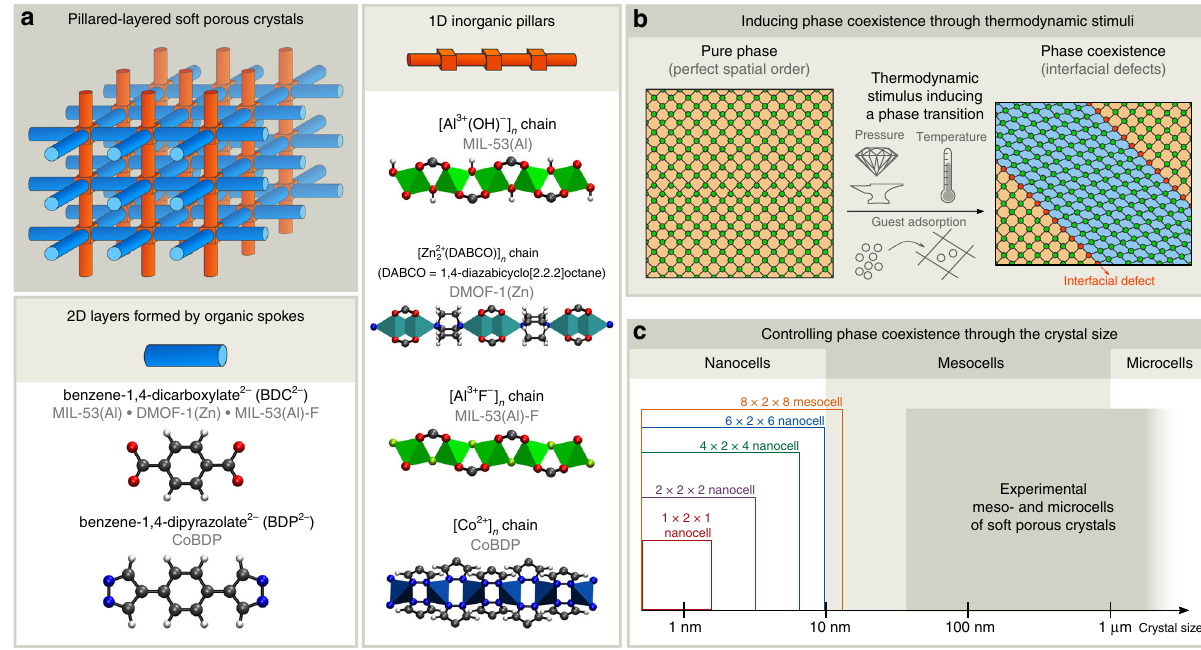
Fig. 1 Inducing size-dependent phase coexistence in pillared-layered SPCs using various thermodynamic stimuli. a Atomistic representation of the building blocks of the SPCs discussed in this work: MIL-53(Al), DMOF-1(Zn), MIL-53(Al)-F, and CoBDP. Color code: zinc (cyan), cobalt (cobalt blue), aluminum (green), fl uor (lime), oxygen (red), nitrogen (blue), carbon (gray), hydrogen (white). b The three investigated thermodynamic stimuli to induce phase coexistence: pressure, temperature, and guest adsorption. The SPC ’ s metal nodes act as hinges which are either in equilibrium (green) or locally deformed (red). c Classi fi cation of the theoretical and experimental crystal sizes into nanocells, mesocells, and microcells. The color code for the theoretical nano- and mesocells is used consistently throughout this